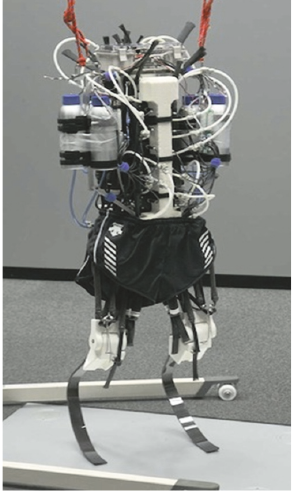
Figure 1: Motion of disabled people with elastic legs.